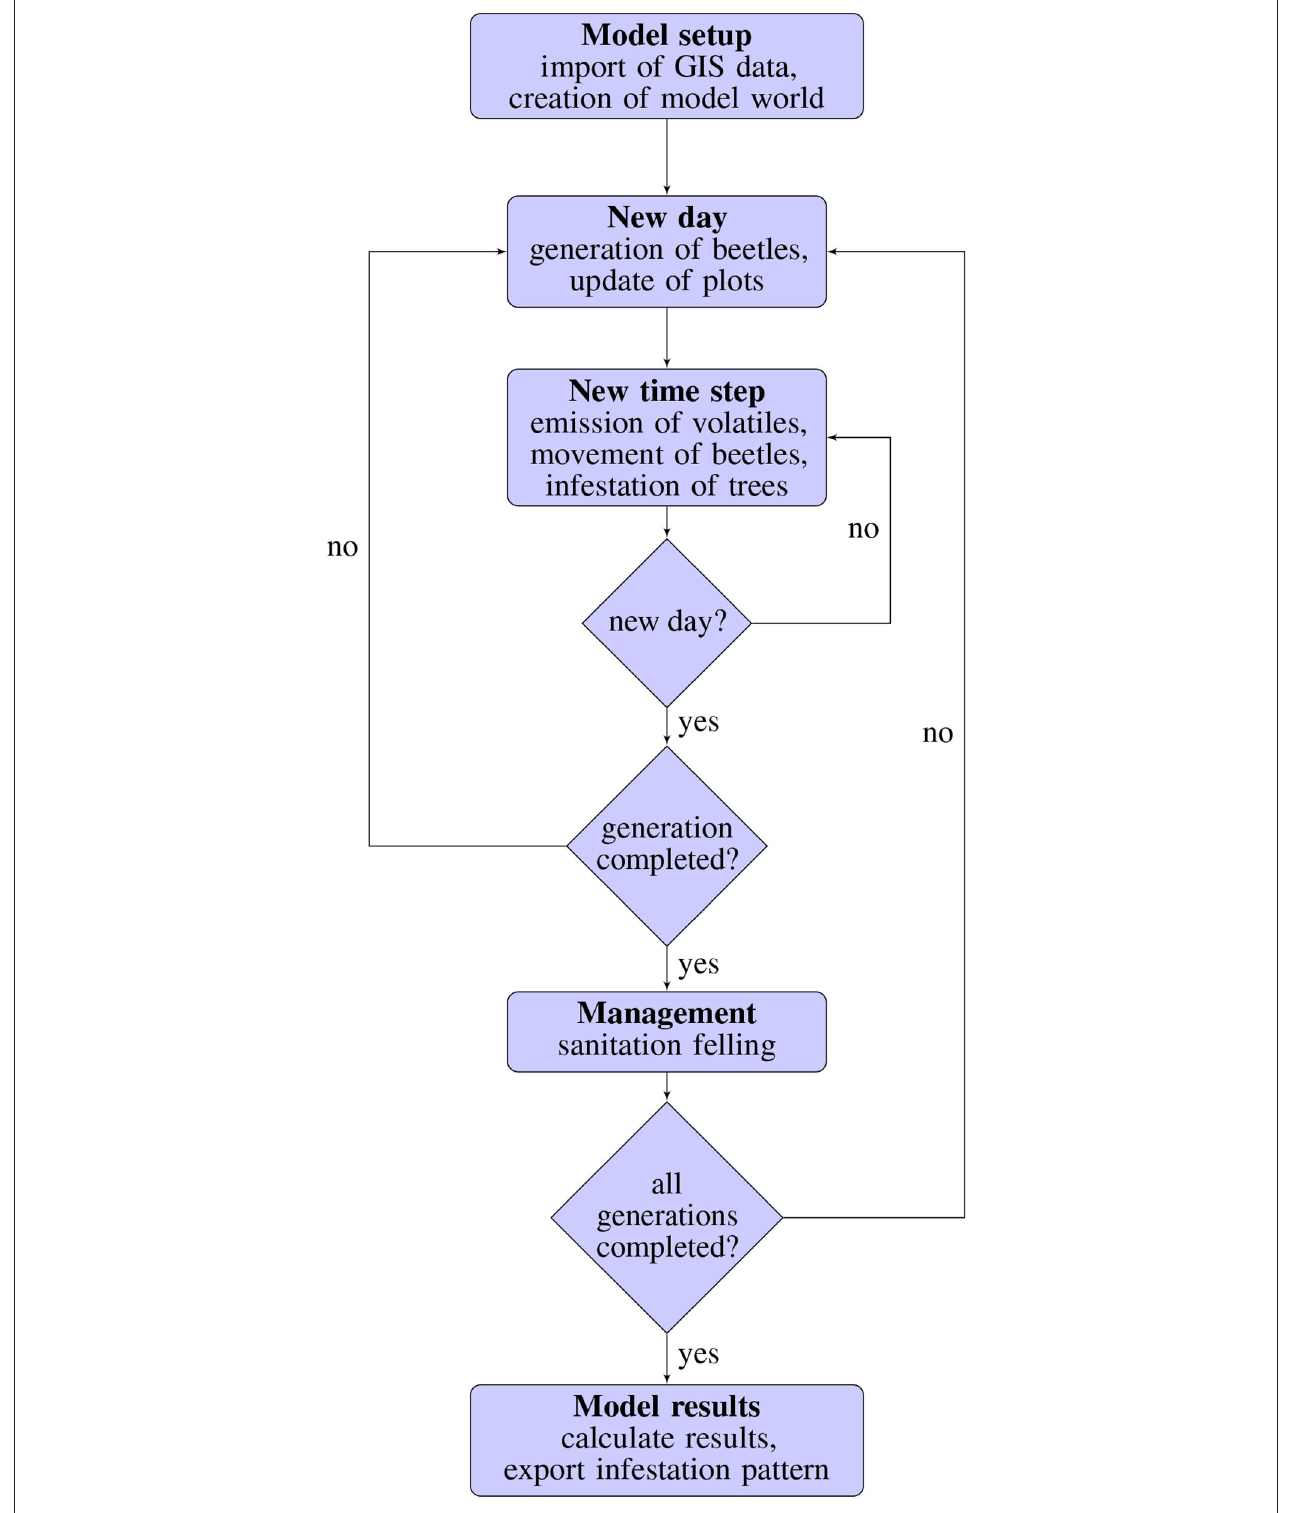
FIGURE 1 | Flow chart showing the schedule for IPS-SPREADS. A new day begins every 200 time steps.